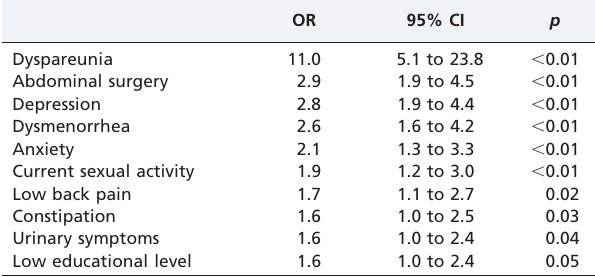
Table 3 - Variables independently related to chronic pelvic pain identified by logistic